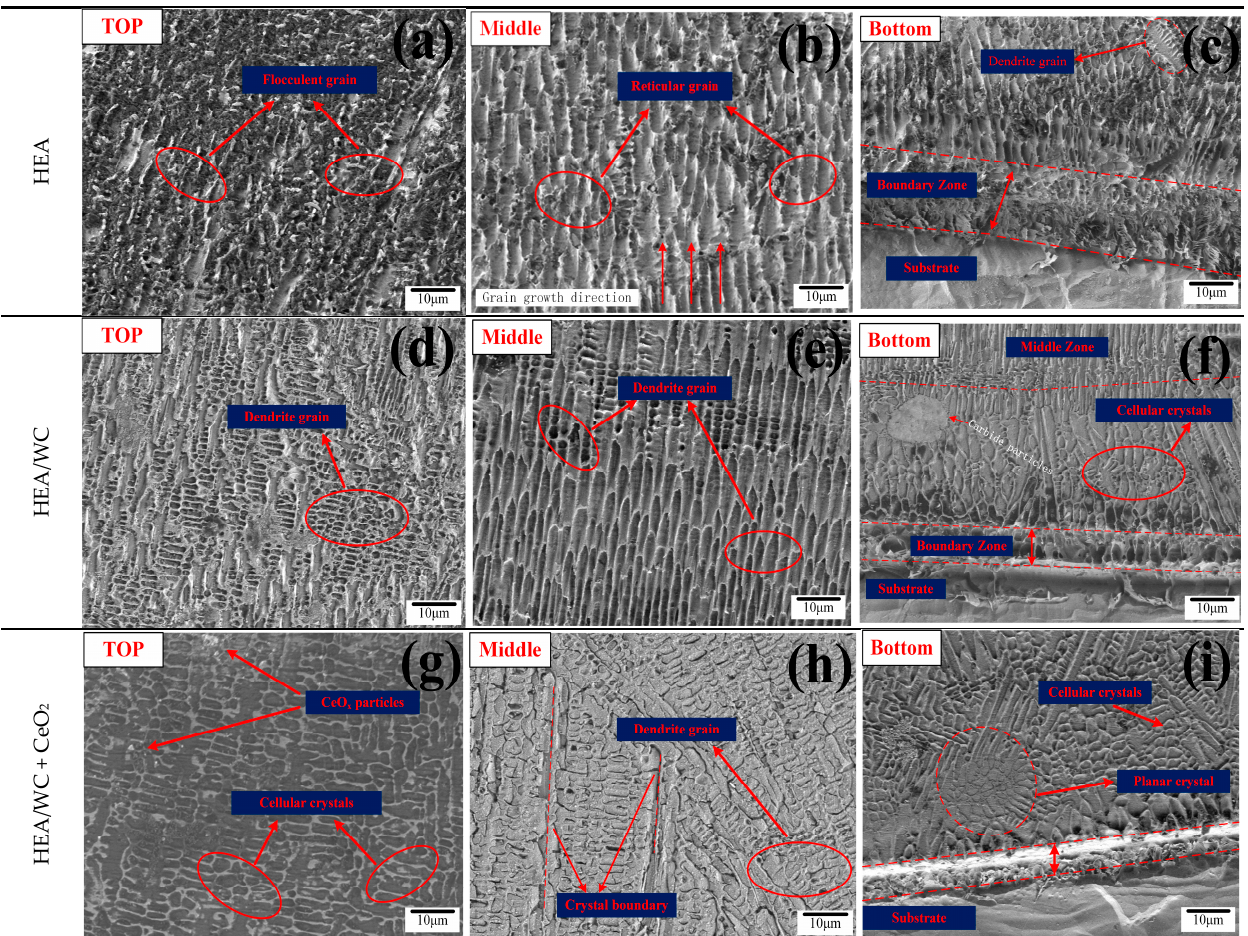
Figure 5. The microscopic morphology of the three coatings: ( a – c ) HEA; ( d – f ) HEA/WC; ( g – i ) HEA/WC + CeO